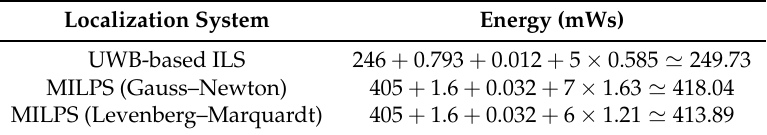
Table 10. List of measured energy consumption of the UWB-based ILS and the MILPS for a position